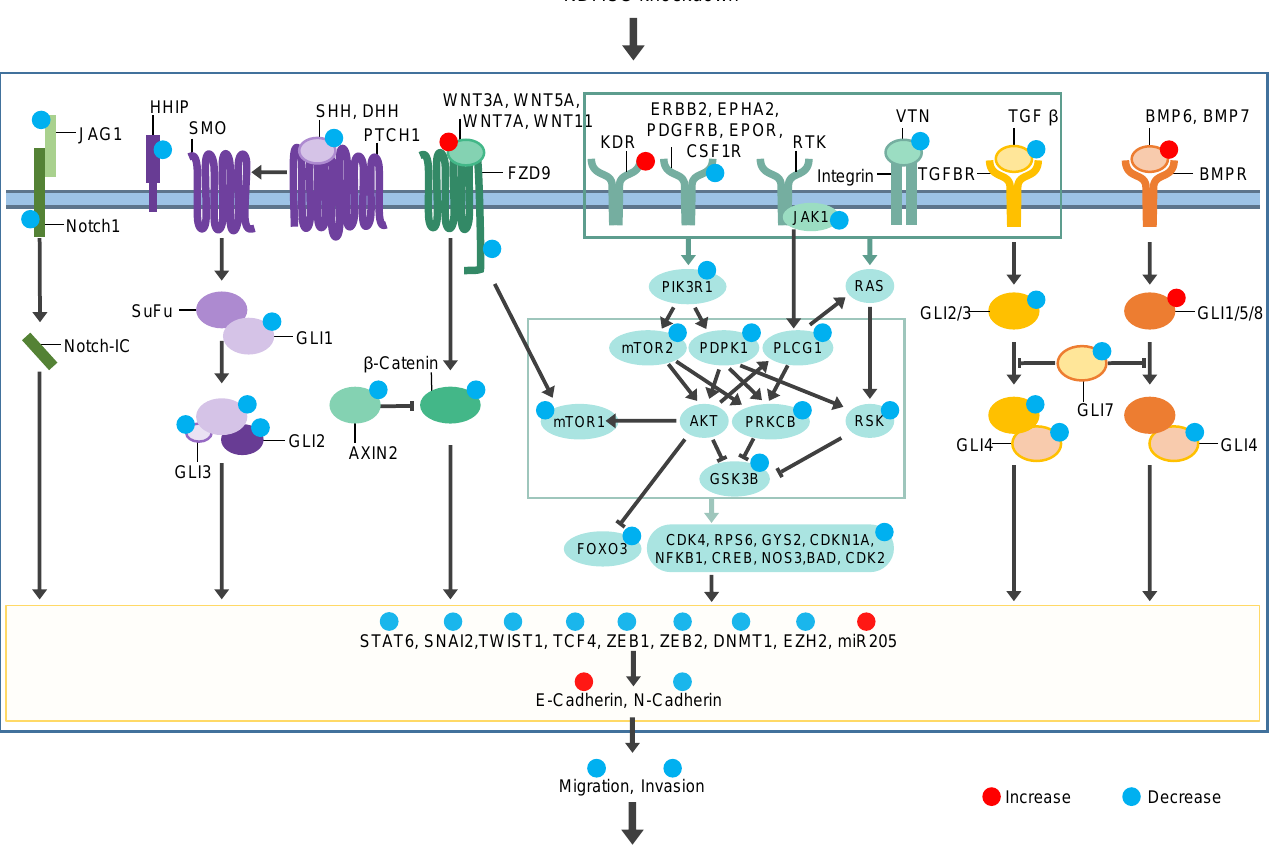
Figure 8. Simplified model of our results on the role of KDM5C in prostate cancer. KDM5C knock- down leads to downregulation of signaling pathways and transcription factors involved in EMT. E-cadherin expression is increased, and N-cadherin expression is decreased after KDM5C knockdown which results in MET.